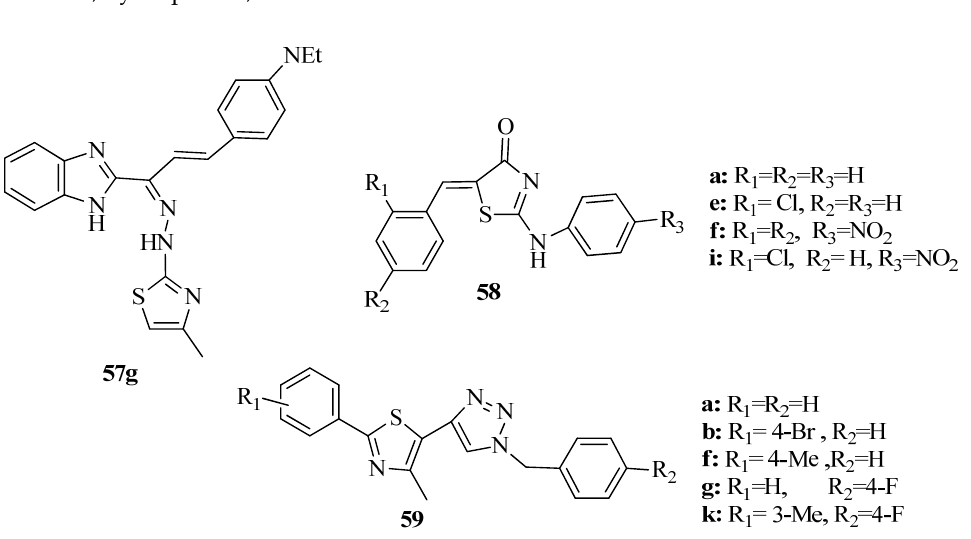
Figure 22. Structures of benzimidazolallylidenehydrazinylmethylthiazole derivatives, ( Z )-5- (substituted benzylidene)-2-((substituted phenyl)amino)thiazol-4(5H)-one analogues, and 5-(1- benzyl-1H-1,2,3-triazol-4-yl)-4-methyl-2-arylthiazole derivatives.